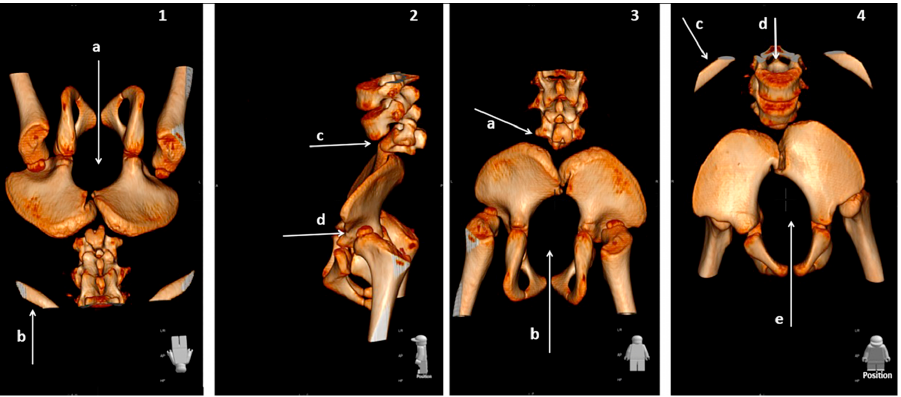
Figure 5. 3D reconstruction of a CT-SCAN showing the vertebral and hip abnormalities. ( 1 ) Inverted position for a better view of the hypoplastic L3 vertebra. The arrow marked “a” shows the sacral agenesis, while arrow b indicates the 12th rib (to show where the lumbar column begins); ( 2 ) In this sagittal view, arrow c shows the hypoplastic L3 vertebra and arrow d shows the lack of articular congruence between the head of the femur and the abnormal left hip acetabulum; ( 3 ) Posterior view, in which arrow a shows the abnormal L3 and arrow b shows the sacral agenesis. Notice too the iliac bones articulated in the midline, the rotation of the hips, the incomplete development of both acetabulae, and the luxated femoral heads; ( 4 ) Oblique view for seeing the spinal cord (arrow d). Arrow c shows the 12th rib and arrow e shows the sacral agenesis. Note, again, the articulation of the iliac bones and the rotation of the left